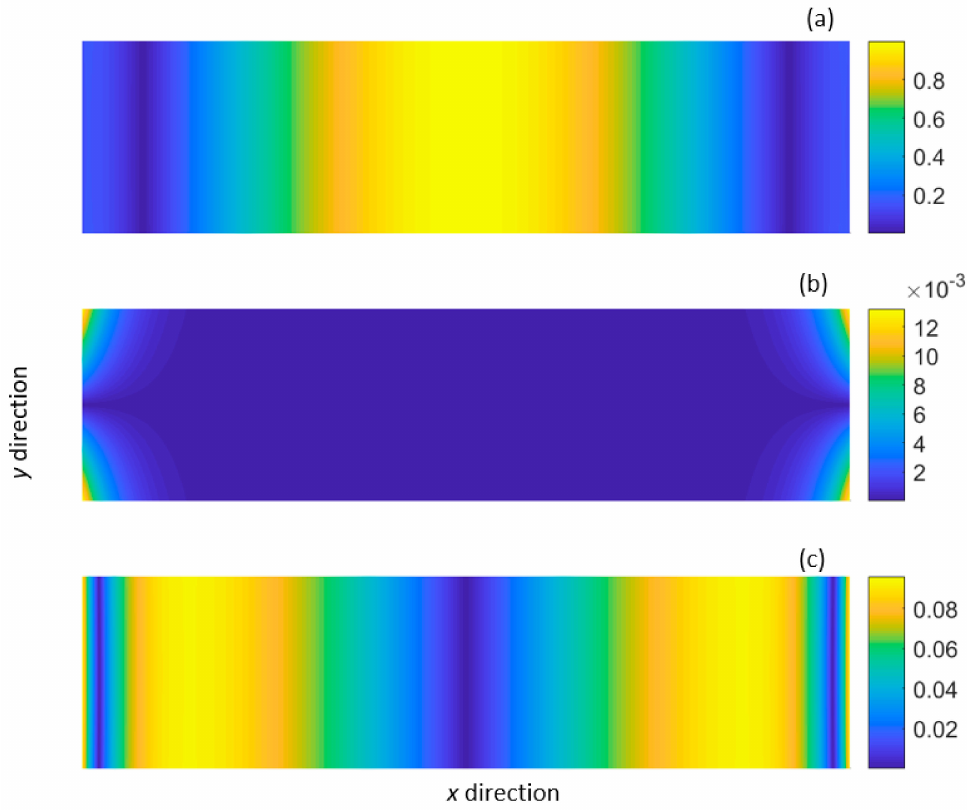
Figure 7. Normalised displacement distribution of the shear-horizontal type mode (SH0*): ( a ) shear displacement ( x direction); ( b ) vertical displacement ( y direction); ( c ) extensional displacement ( z